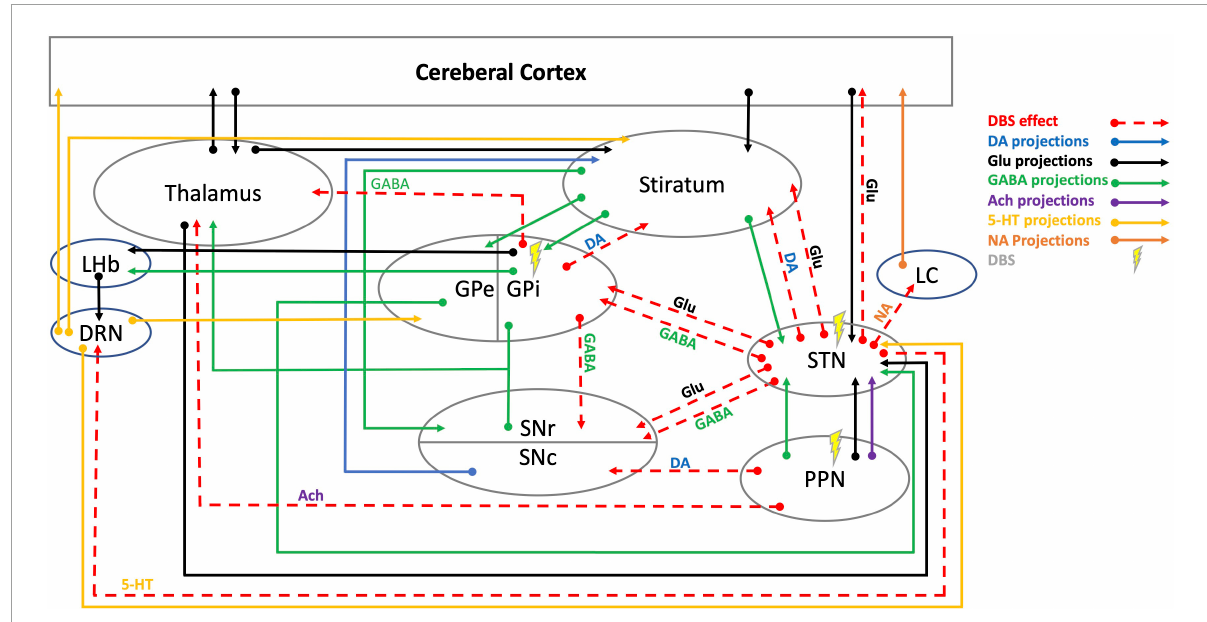
FIGURE1 Schematic illustration of DBS neurotransmitter mediation in cortico-thalamic-basal ganglia-brainstem circuits. 5-HT, 5-hydroxytryptamine (serotonin); Ach, acetylcholine; DA, dopamine; DBS, deep brain stimulation; DRN, dorsal raphe nucleus; GABA, γ -aminobutyric acid; Glu, glutamate; GPe, globus pallidus external; GPi, globus pallidus internal; LC, locus coeruleus; LHb, lateral habenula; NA, noradrenaline; PPN, pedunculopontine nucleus; SNc, substantia nigra pars compacta; SNr, substantia nigra pars reticulata, STN, subthalamic nucleus. DBS effects data are cited in Table 1